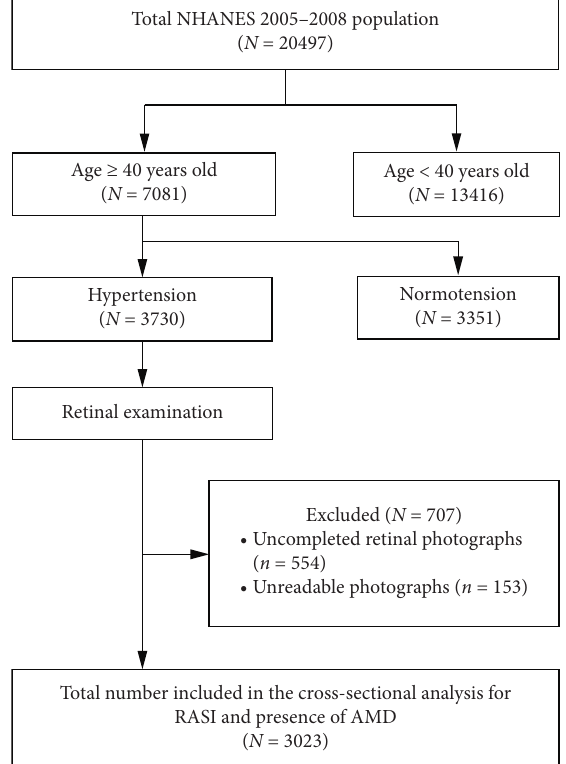
Figure 1: Population selection to obtain the final participants for assessment of the relationship between RASIs and AMD